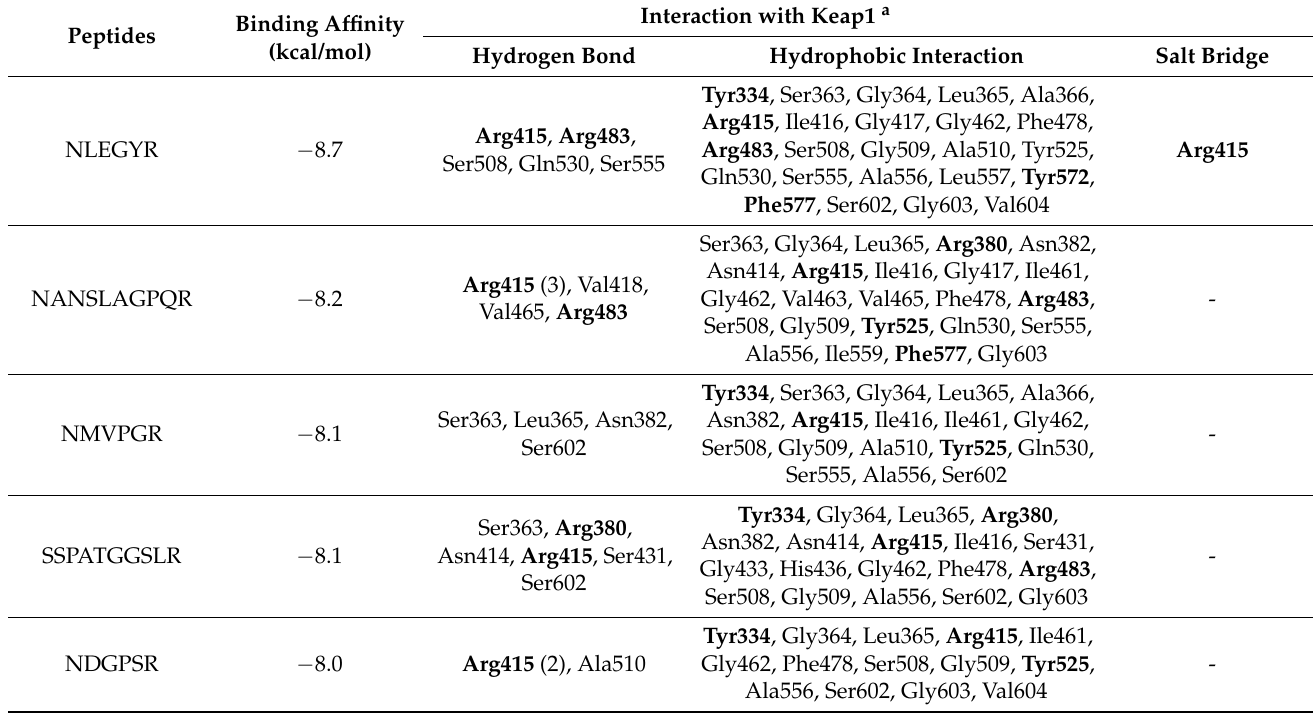
Table 6. Binding affinities and types of interactions between Kelch-like ECH-associated protein 1 (Keap1) and five corn silk peptides predicted as non-toxic, non-allergenic and cell-penetrating peptides, in comparison with a reference peptide.